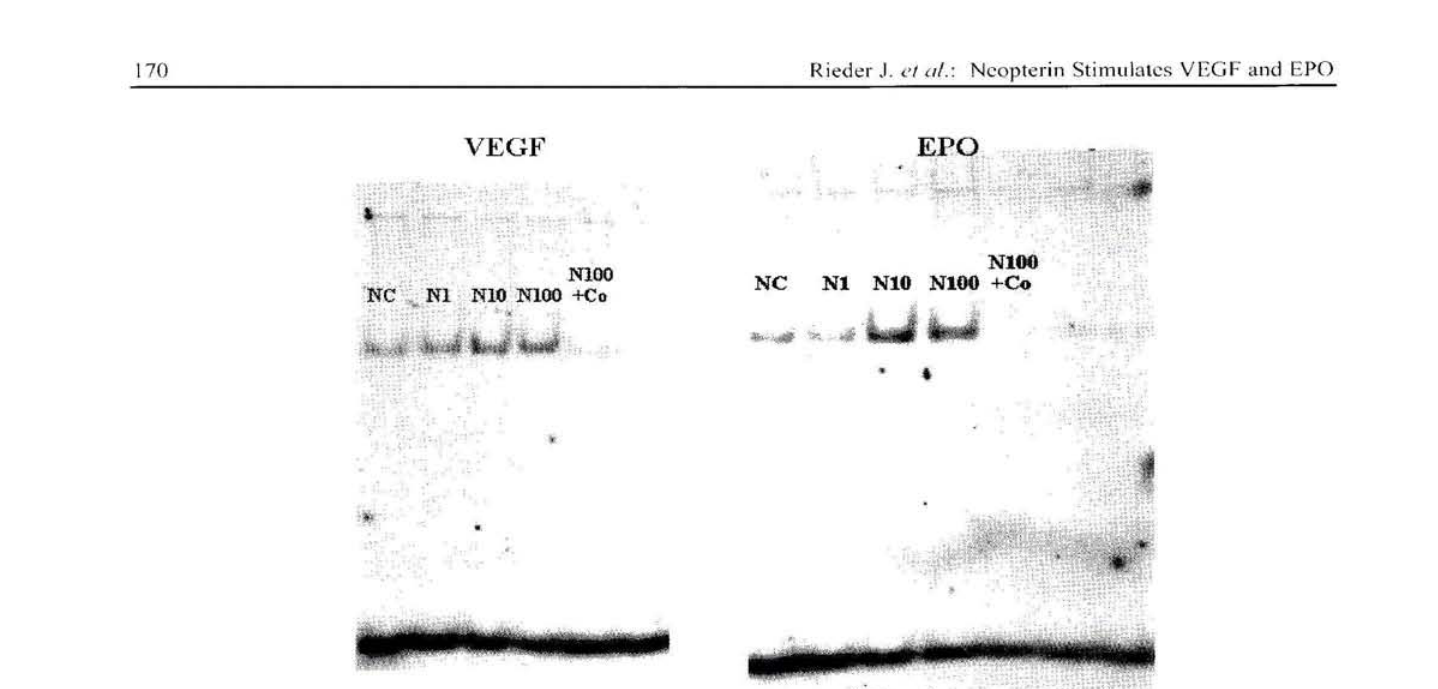
Figure 3. Activation of hypoxia inducible factor-1 (HI F-1 ) under normoxie conditions dctccted by clectrophorctic mobility shift assay in nuclear extracts of OVCAR-3 cells following 1 h-incubations with ncopterin at concen- trations of 1 μΜ (N 1 ), 10 μΜ (Ν 1 0), and 100 μΜ (Ν 100). Nuclear extracts were incubatcd with digoxigenin-11- ddUTP-labeled oligonucleotide probes representing HIF-1 consensus binding sequences either within the pro- moter of the human vascular endothelial growth factor (VEGF) gene or within the enhanccr segment of the human erythropoietin (FPO) gene. NC indicates normoxie controls. Co symbolizes an unlabeled oligonucleotide control probe. Results are representative of three different experiments.